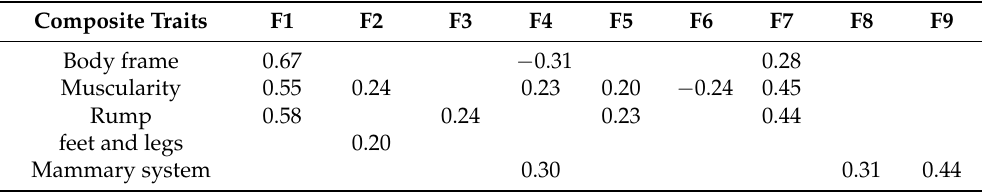
Table 6. Spearman correlation coefficients (only values ≥ | 0.20 | ) between EBVs estimated for body conformation traits and EBVs obtained from 9 factor scores (from F1 to F9) in dual-purpose Simmental cattle.